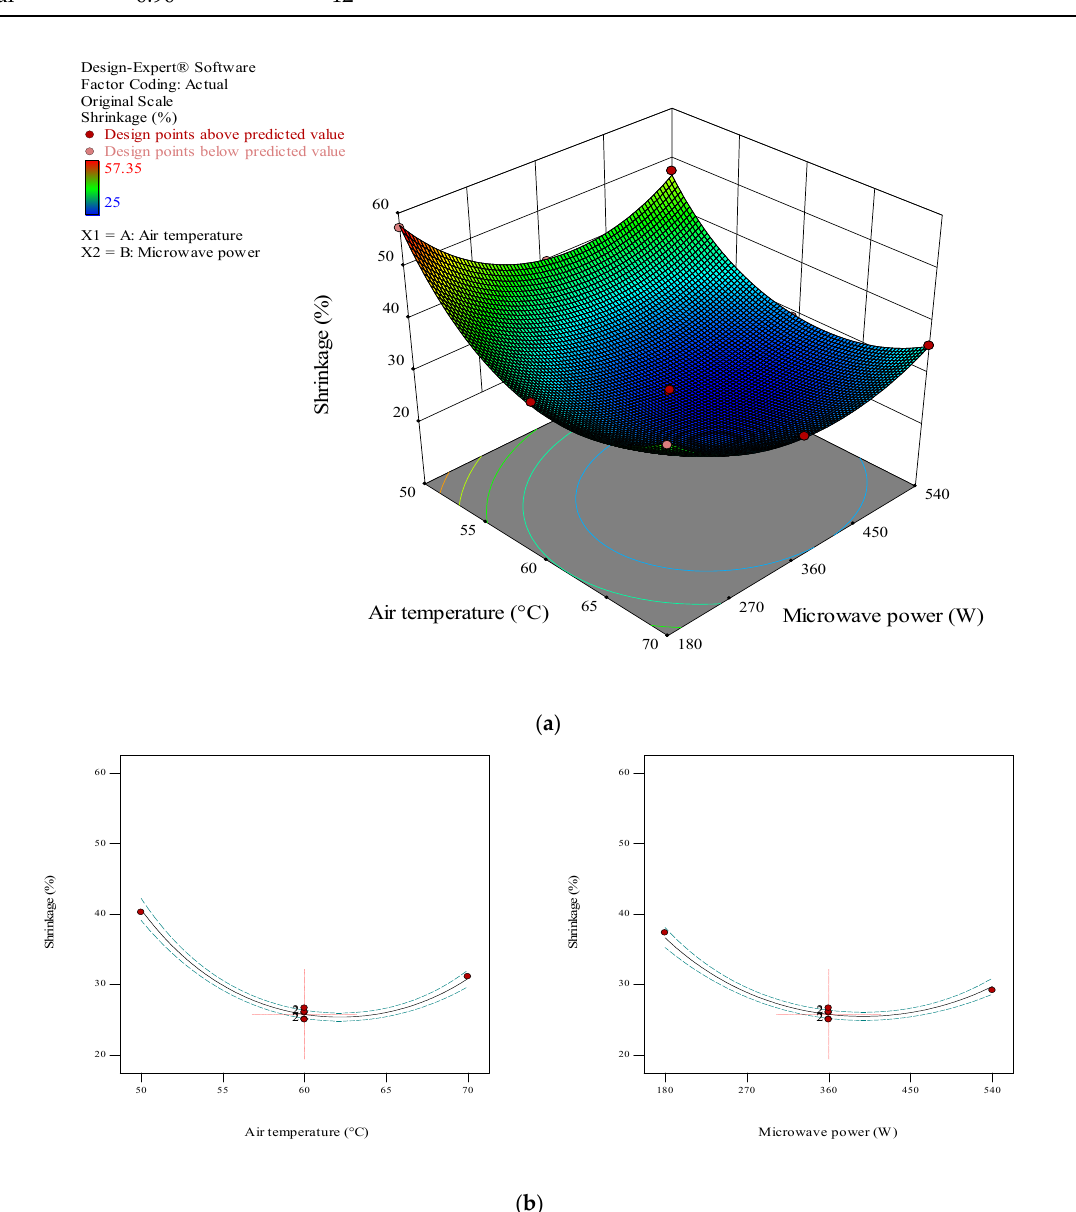
Figure 4. ( a ) The combined effect of air temperature and microwave power on shrinkage ( b ) The effect of air temperature and microwave power alone on shrinkage.